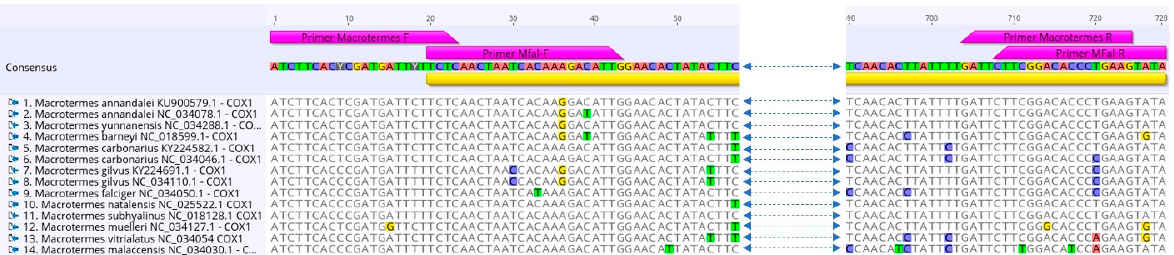
Figure 6. Alignment of COI sequences extracted from 14 complete mitochondrial genomes of Macrotermes available on GenBank. The primers Mfal-F and Mfal-R are specific for M. falciger and were designed for PCR amplification and sequencing of the standard DNA barcoding region (709 bp) in African Macrotermes . Macrotermes-F and Macrotermes-R represent theoretical universal primers for DNA barcoding (724 bp) of African and Asian Macrotermes .